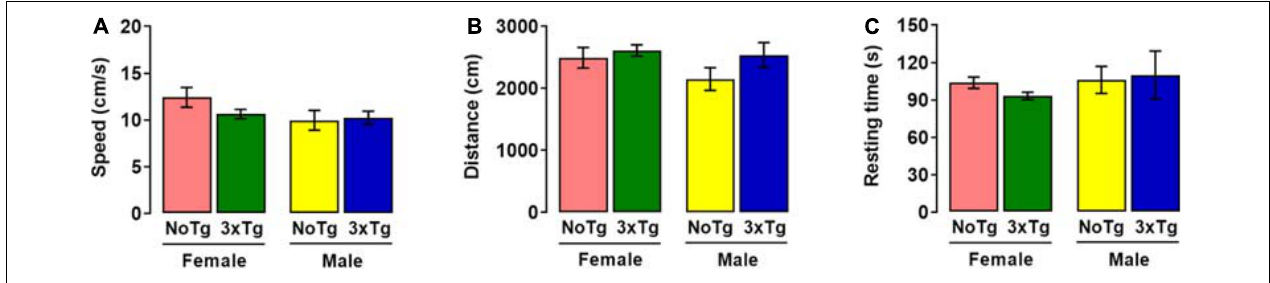
FIGURE 2 | Motor activity during habituation session of novel-object localization (NOL) task. Mean values (with standard error) of (A) speed, (B) distance traveled, and (C) resting time of female or male non-transgenic (NoTg) or Alzheimer’s disease triple-transgenic (3xTg-AD) mice of 5 months old; n = 10 mice per group.